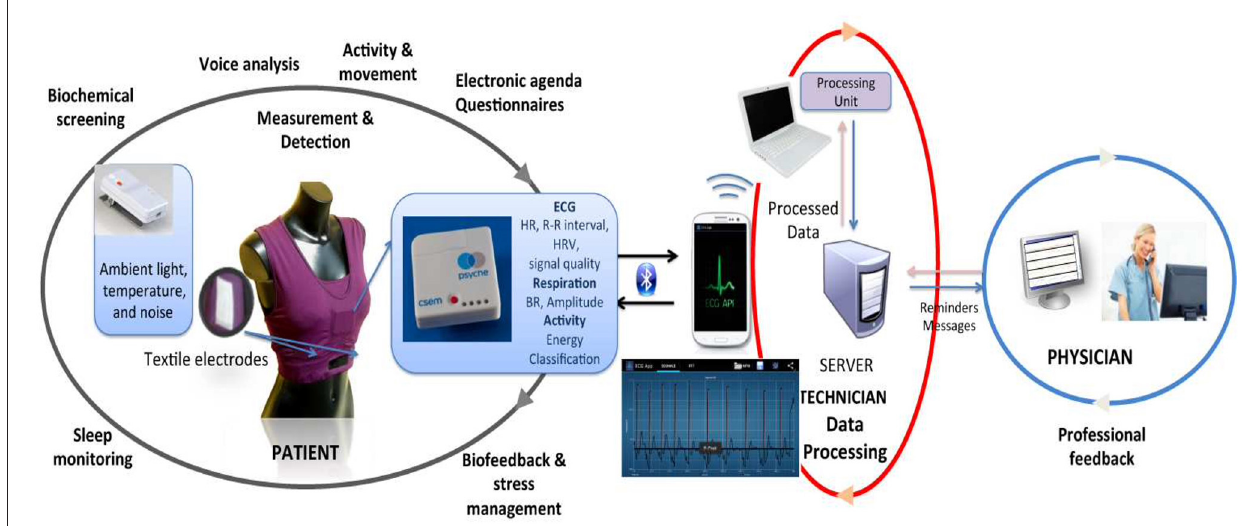
FIGURE 8 | Overview of the PSYCHE wearable monitoring system. The system involves a T-shirt with embedded textile sensors, mobile application for physiological signal acquisition from the wearable platforms, and feedback to patient and clinician [Modified from Lanata et al., IEEE Journal of Biomedical and Health Informatics , 2015